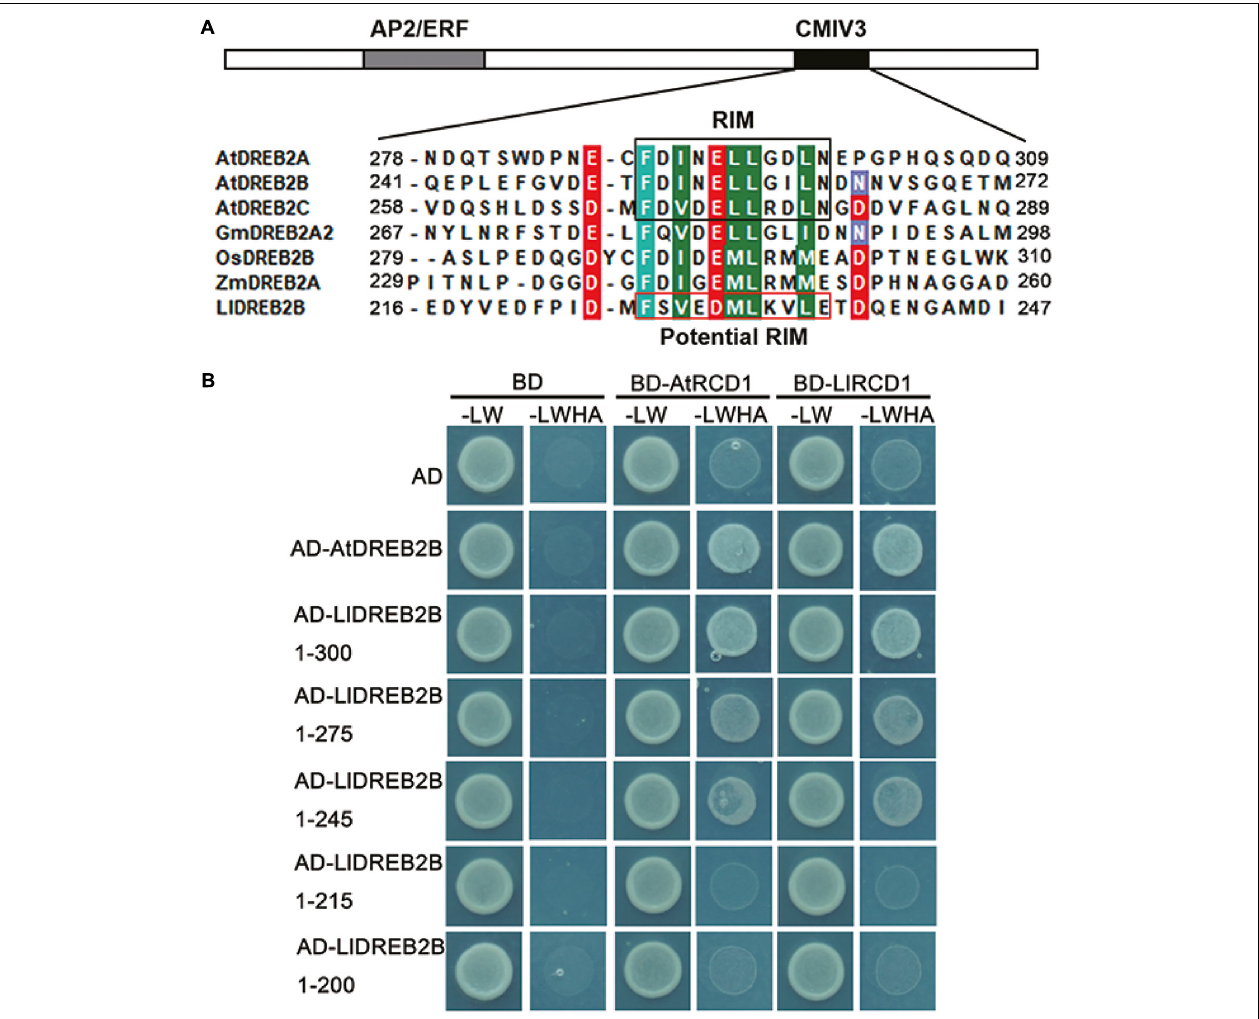
FIGURE 7 | RCD1 interacts with LlDREB2B. (A) Alignment of the CMIV-3 sequences of different DREB2s showing conserved amino acids. The conserved RIM motif is shown in black box; LlDREB2B has a potential RIM motif (red box). (B) Interaction of different regions of LlDREB2B with LlRCD1 and AtRCD1 determined by